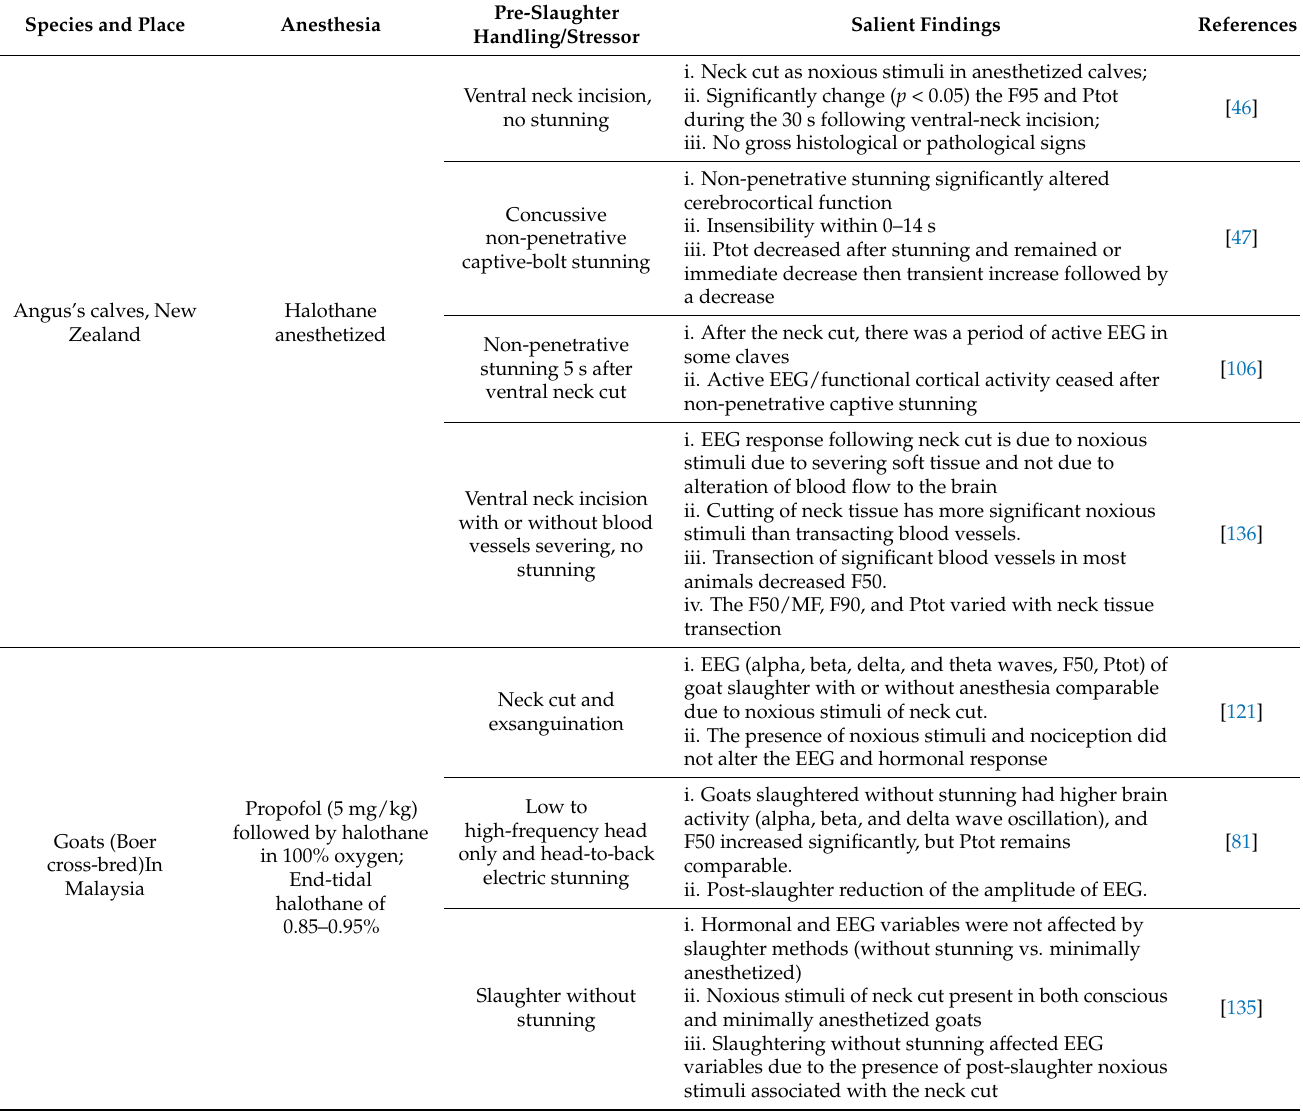
Table 3. Electroencephalogram under MAM slaughter of